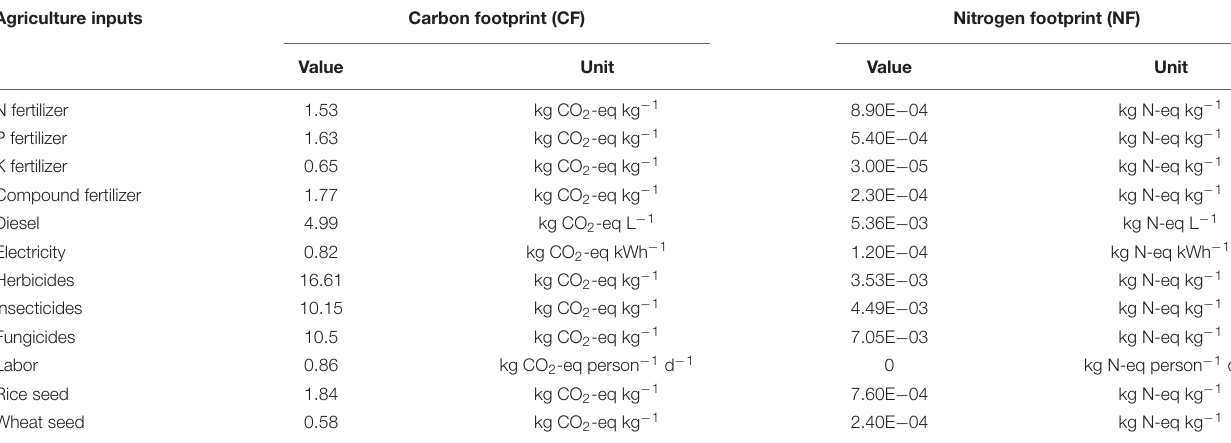
TABLE 3 | Emission factors of carbon and nitrogen footprints. Agriculture inputs Carbon footprint